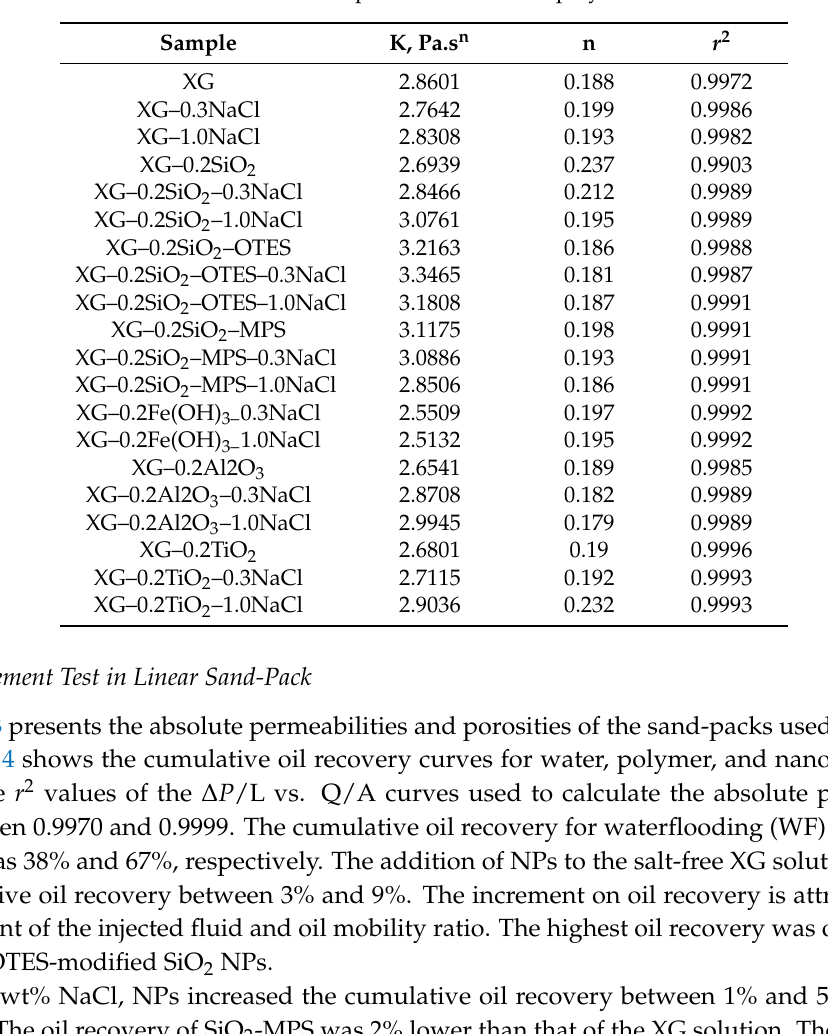
Table 2. Power law parameters for nanopolymer